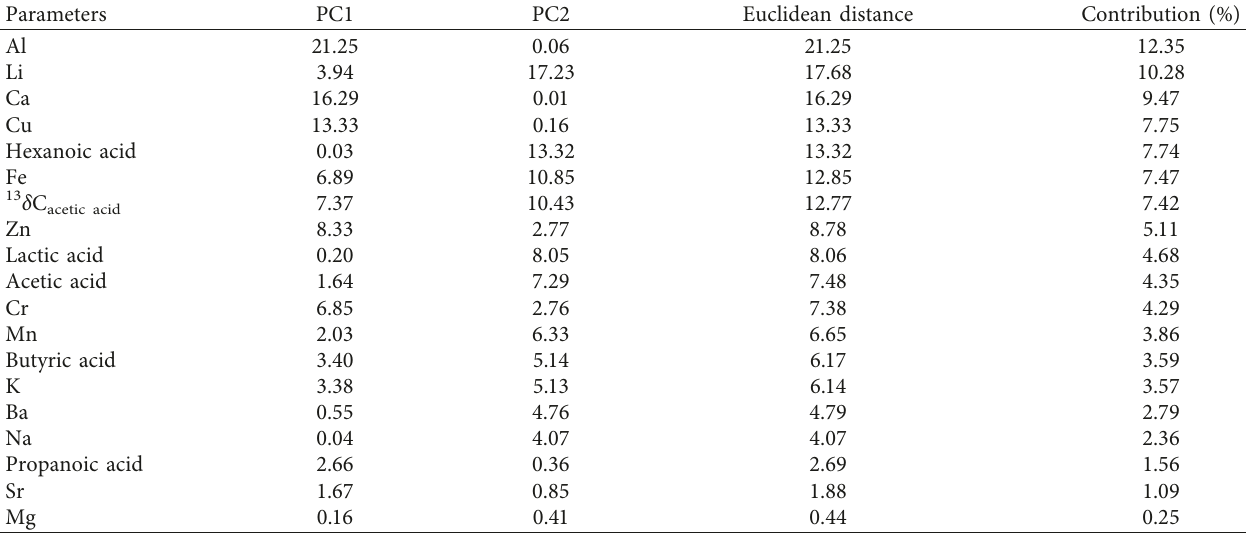
Table 4: Nineteen parameters of variables on two principle components of principal component analysis from seven different origins.